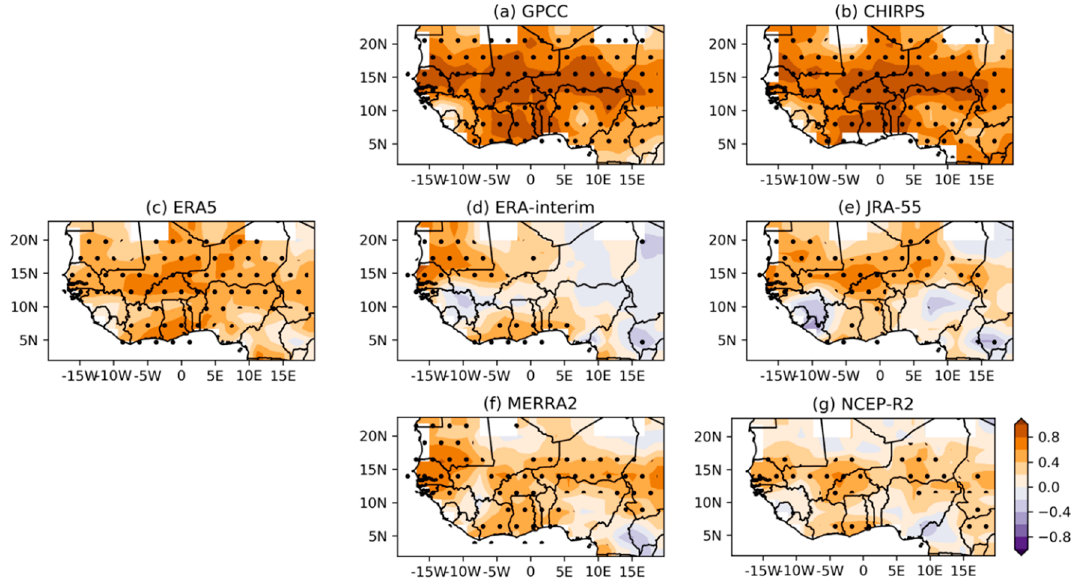
Figure 5. Correlation coefficient (r) maps of pixel-wise temporal correlation of the annual mean JJAS precipitation (mm day − 1 ) between CRU and other observational and reanalysis datasets. Stippling denotes statistically significant correlations at the 5% significance level.